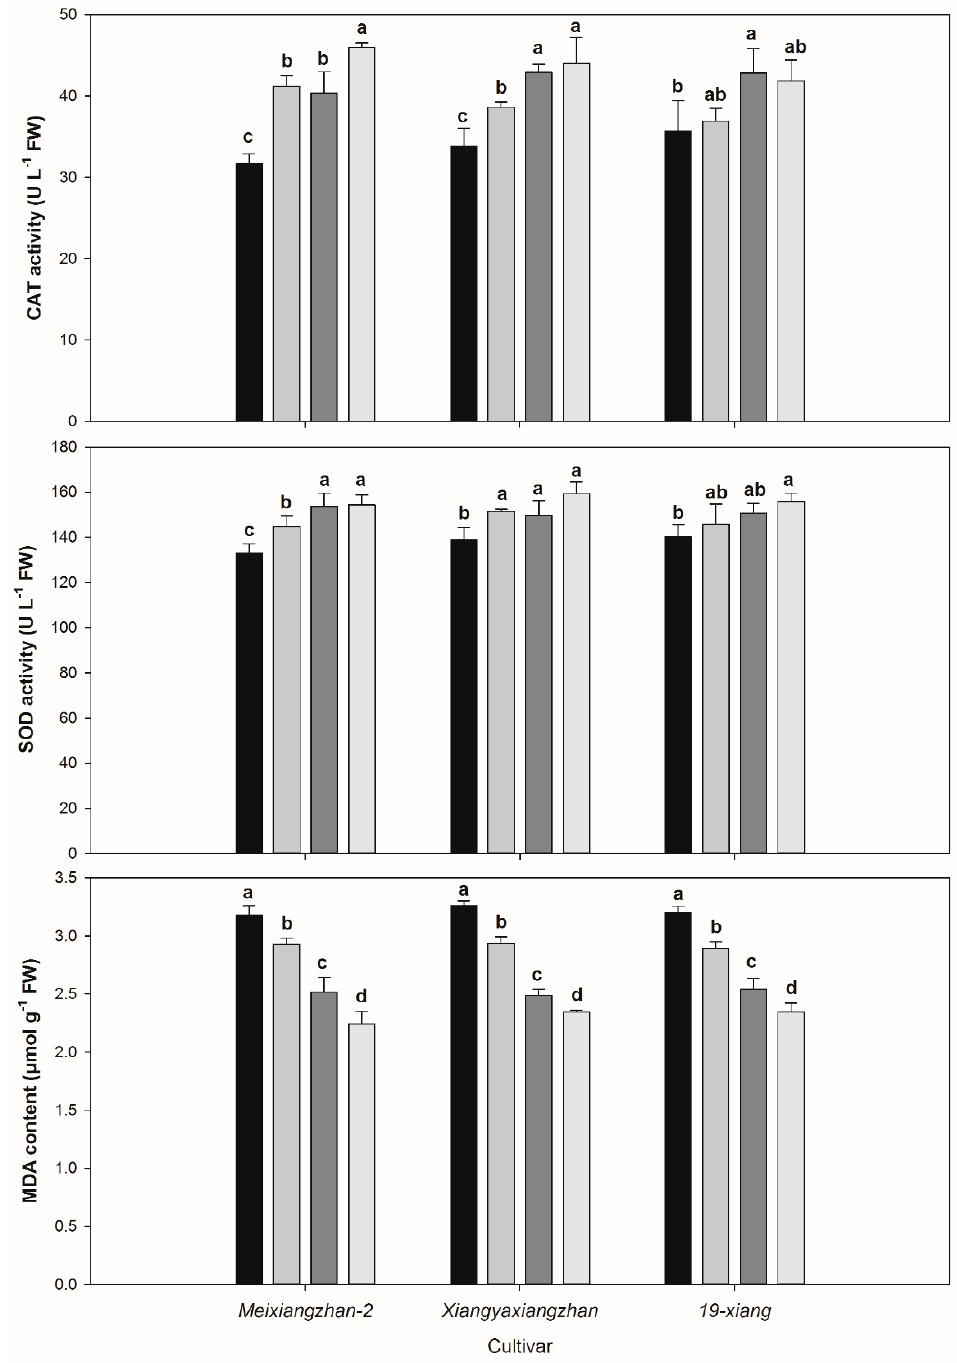
Figure 4. Effects of vermicompost incorporation on activities of POD, SOD, and CAT, as well as content of MDA, of fragrant rice seedlings; those sharing a common letter do not differ significantly at p < 0.05 according to the least significant difference (LSD) test for three fragrant rice cultivars.